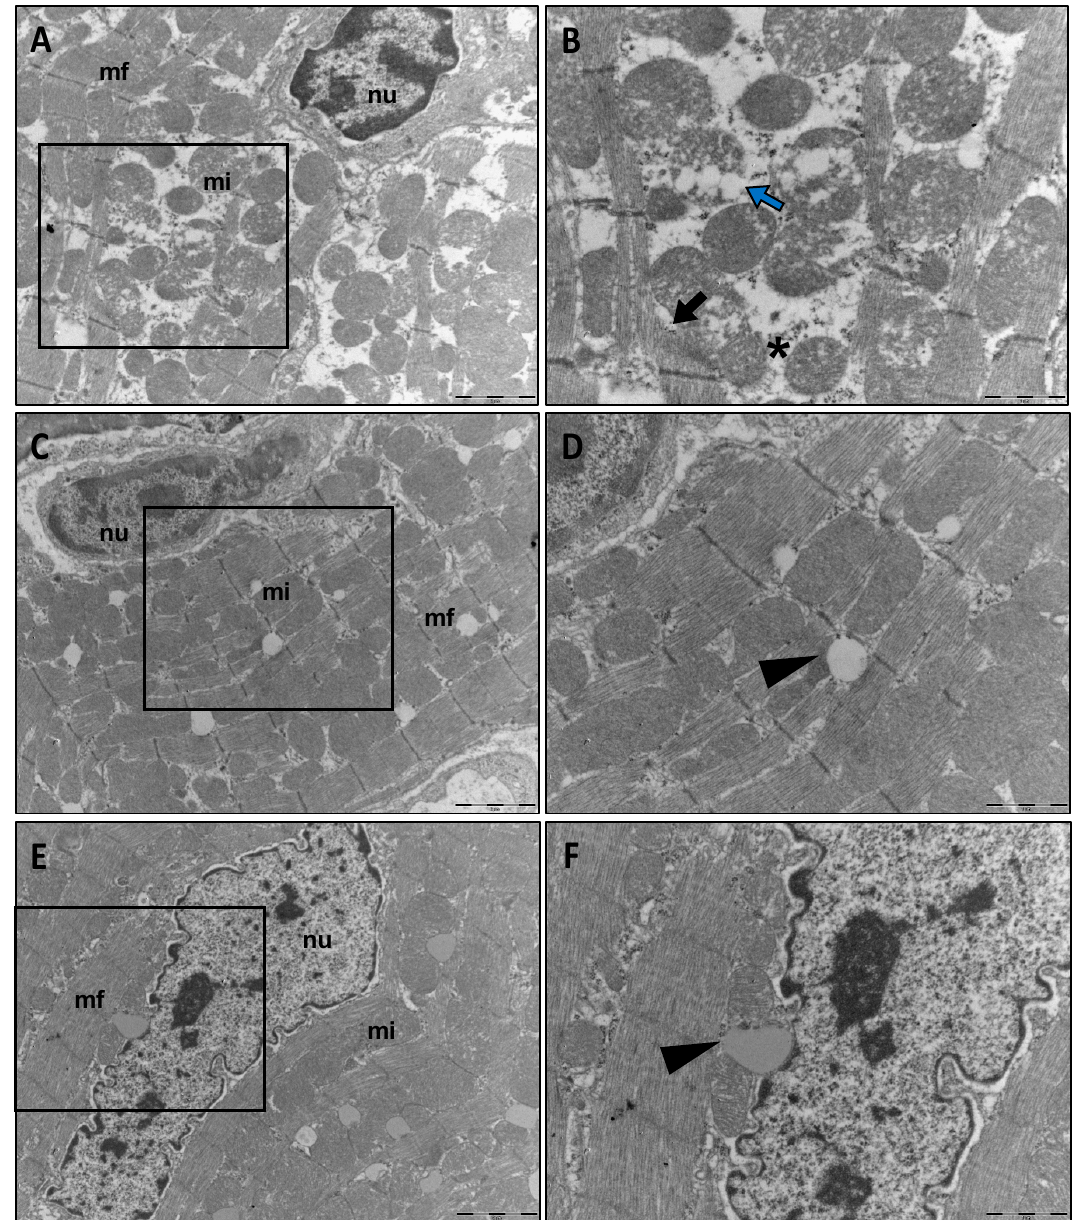
Figure 3. Myocardial ultrastructural changes in CLP-induced sepsis. Assessment of the ventricular myocardium in the untreated CLP septic group after 120 h ( A , B ) reveals edema and mitochondrial lysis (blue arrow), in addition to interfibrillar edema (asterisk), myofibrillar rupture, and disorientation (black arrow in ( B )). The treated groups CLP + FC ( C , D ) and CLP + NC ( E , F ) showed preserved mitochondria and myofibrils, with some lipid vacuoles (arrowhead). In ( A , C , E ) the bars indicate 2 μ m, and in ( B , D , F ) 1 μ m.